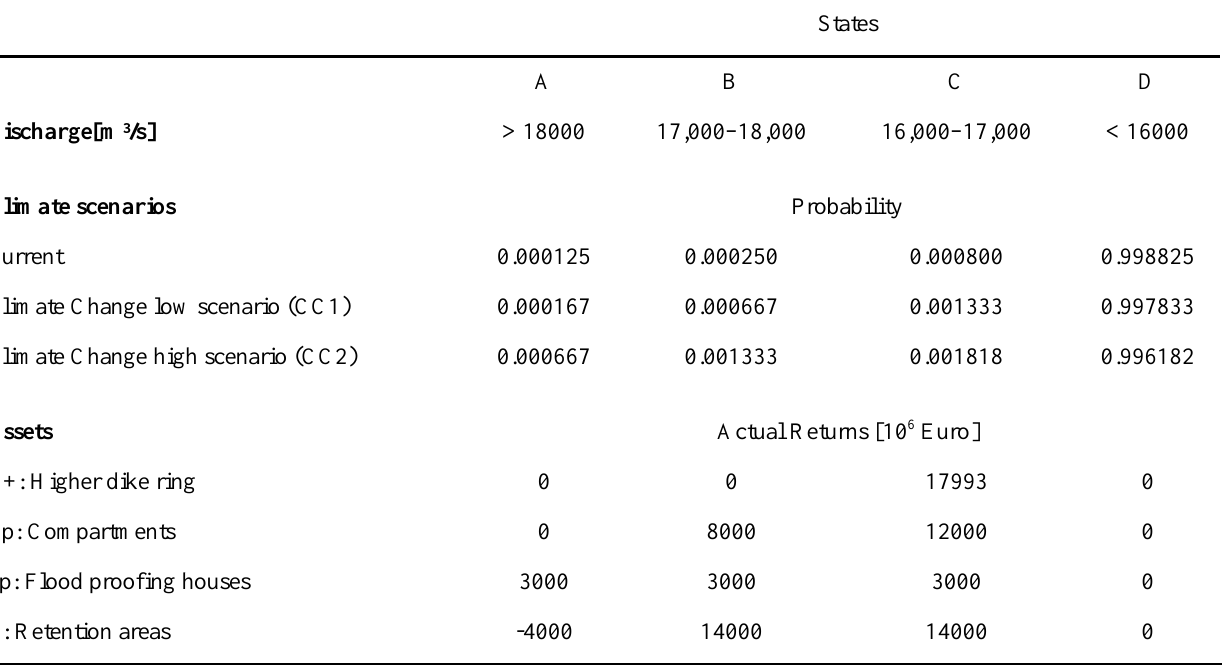
Table 1. Probabilities of the different states, i.e., possible discharges, under three different climate scenarios, e.g., current, climate change low, and climate change high. For each investment, the returns, expressed as prevented damage loss, are showed for each possible states A, B, C, and D (from DWW 2005 a , 2005 b